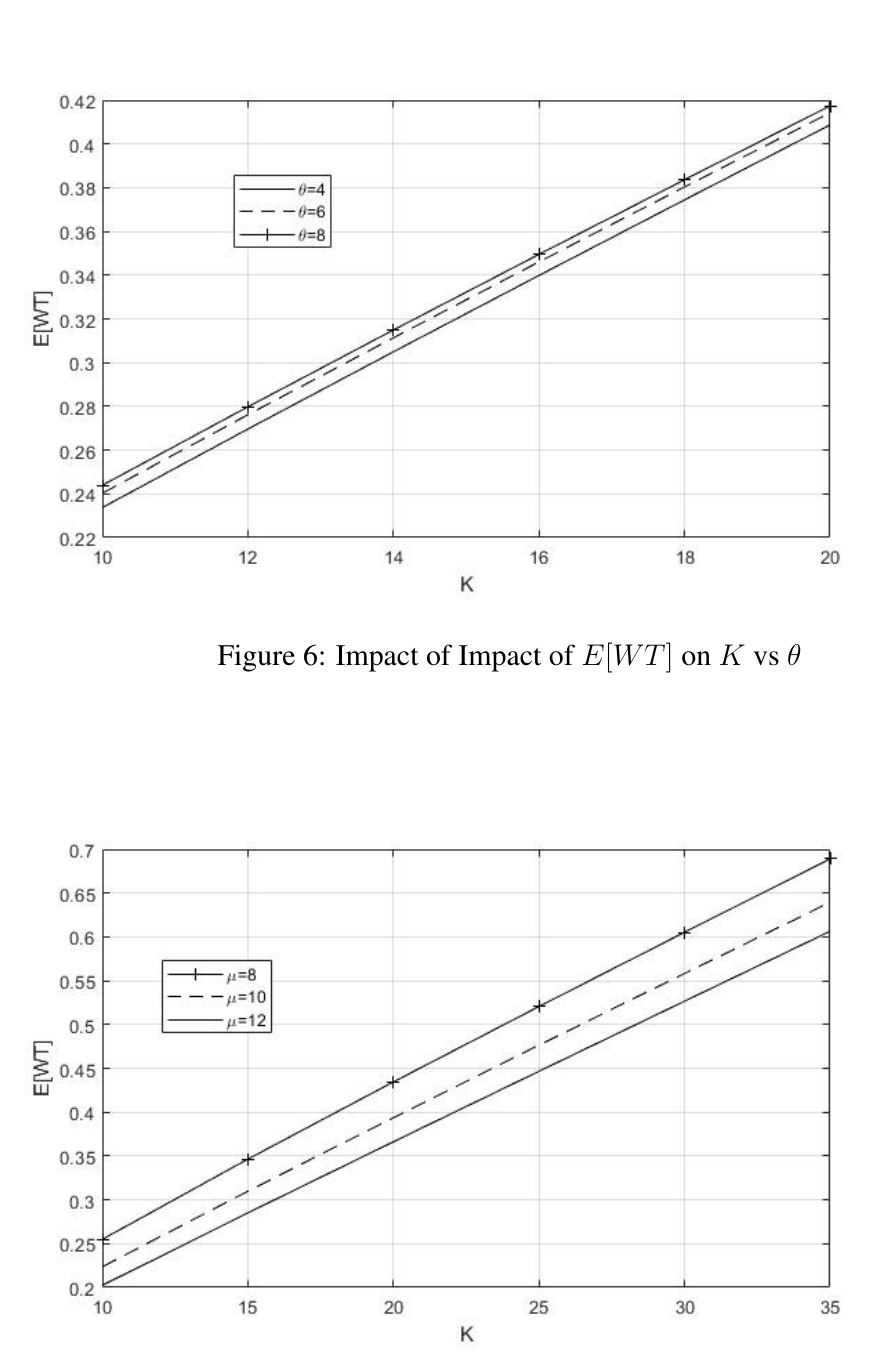
Figure 7: Impact of E [ W T ] on µ vs